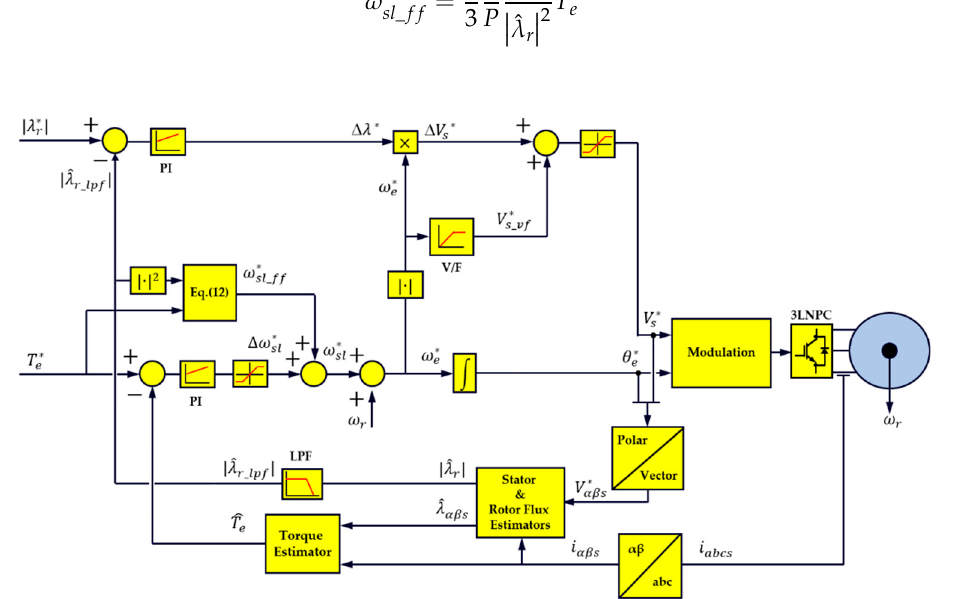
Figure 7. Closed-loop V/F with torque/flux control (CLVFC) scheme.